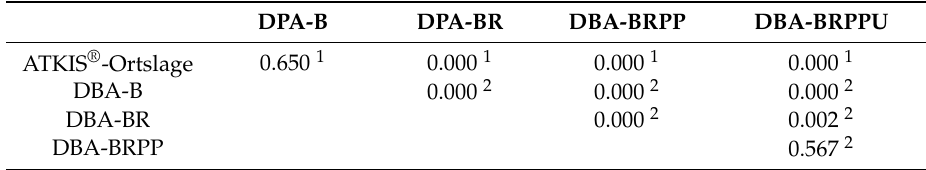
Table 4. Results of testing significance ( p -value).